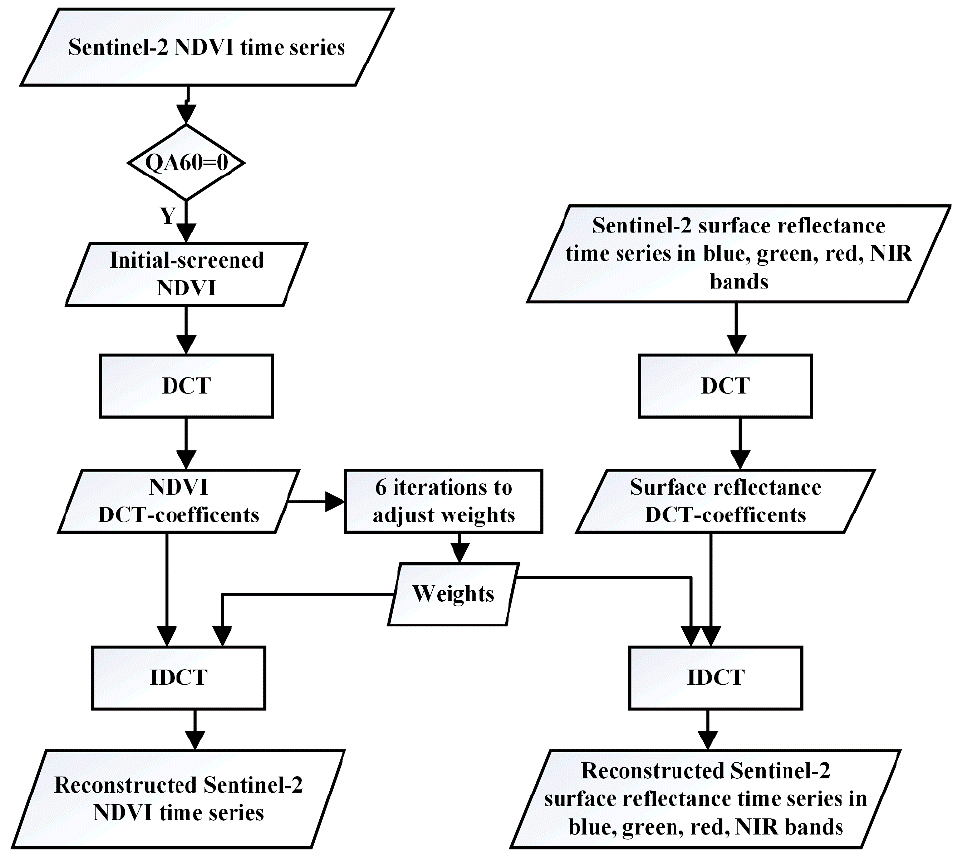
Figure 2. Flow chart of reconstructing Sentinel-2 NDVI and Surface reflectance time series data through the DCT-PLS method.